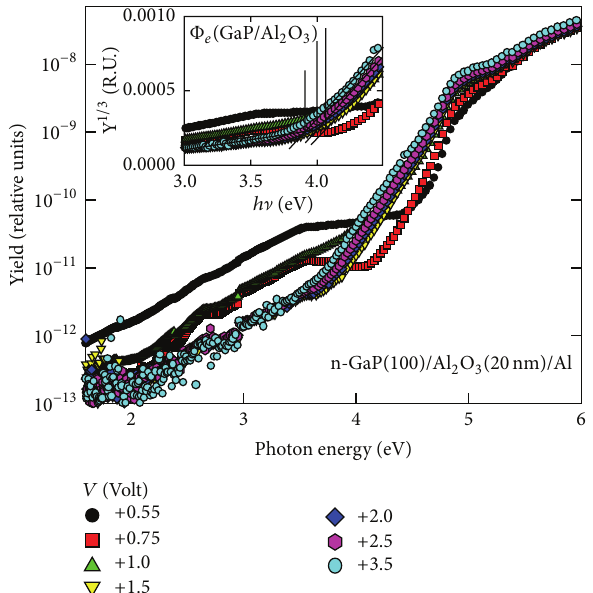
Figure 31: Semilogarithmic plot of the IPE quantum yield as a func- tion of photon energy as measured on (100)GaP/a-Al 2 O 3 (20 nm)/Al sample with the applied bias varying from 0.55 V to 3.5 V. The inset illustrates determination of electron IPE spectral threshold Φ 𝑒 using 𝑌 1/3 - ℎ ] plots. Lines guide the eye.